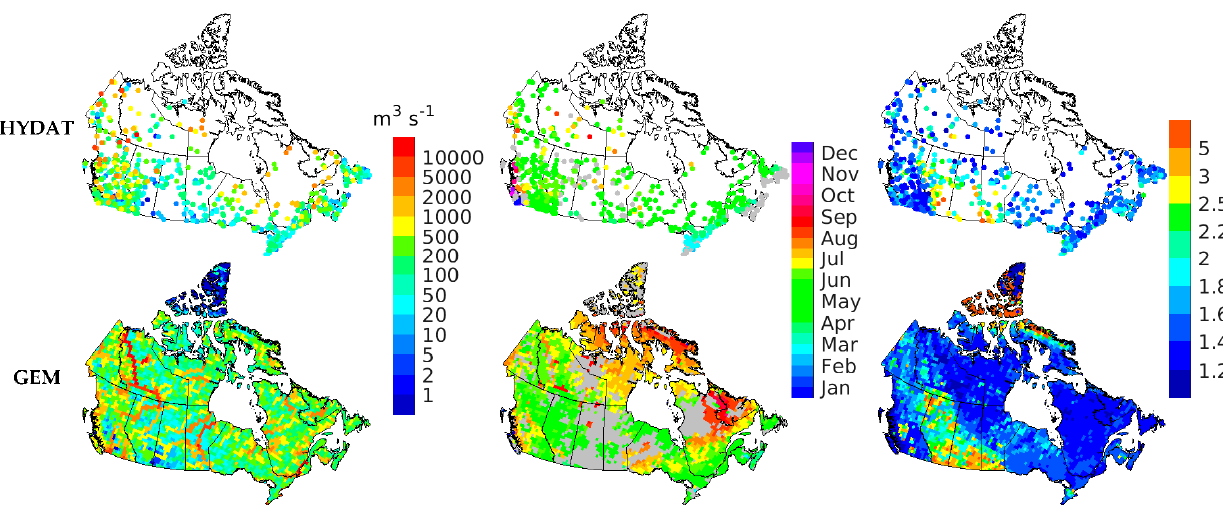
Figure 2. Median annual maximum streamflow (first column), its average date of occurrence (second column), and ratio between 1 in 10-year and median annual maximum streamflow (third column), for the 1971–2020 period, from HYDAT (top row) and GEM (bottom row). Grey is used for the date at locations where less than 50% of annual maximum events occur within 30 days of the average date. Where multiple HYDAT observations overlap, the one with the highest streamflow is shown on top.